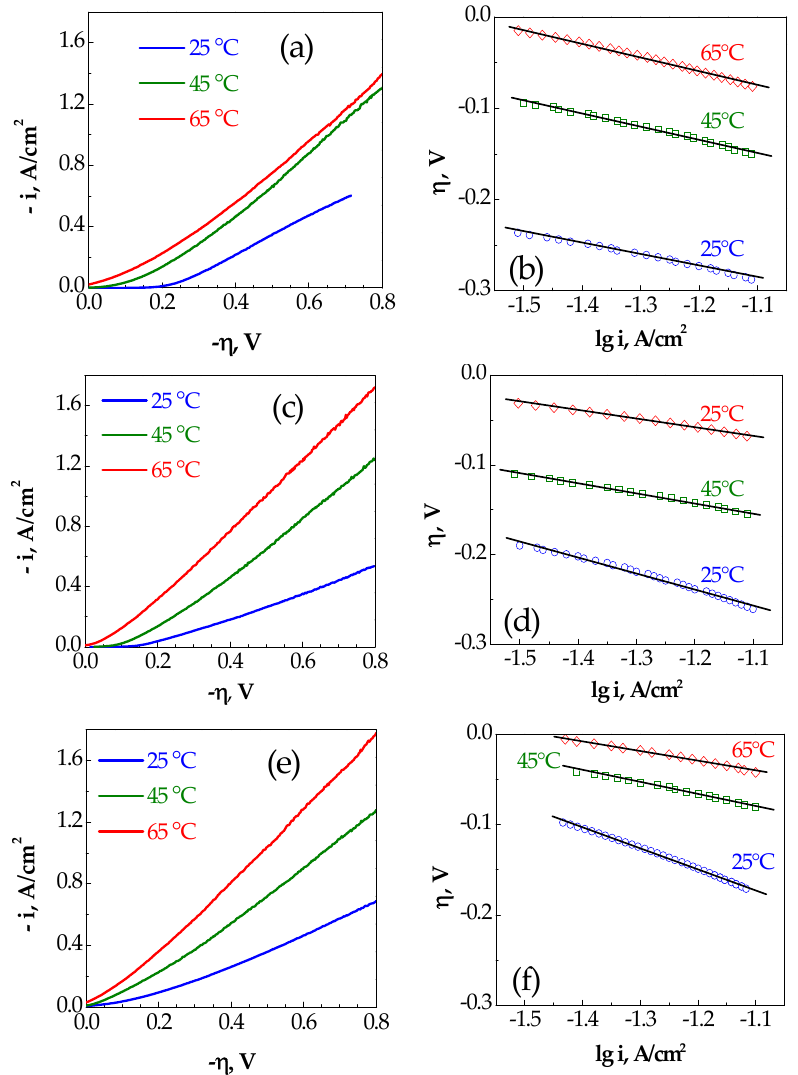
Figure 4. Effect of temperature on cathodic polarization curves at Ni–54 Mo ( a ), Fe–54 Mo ( c ), Co–52 Mo ( e ) electrodeposits in 30 wt.% KOH at different temperatures and plots in semi-logarithmic coordinates for Ni–54 Mo ( b ), Fe–54 Mo ( d ), Co–52 Mo ( f ) electrodes. The scan rate was 2 mV/s (composition is given in